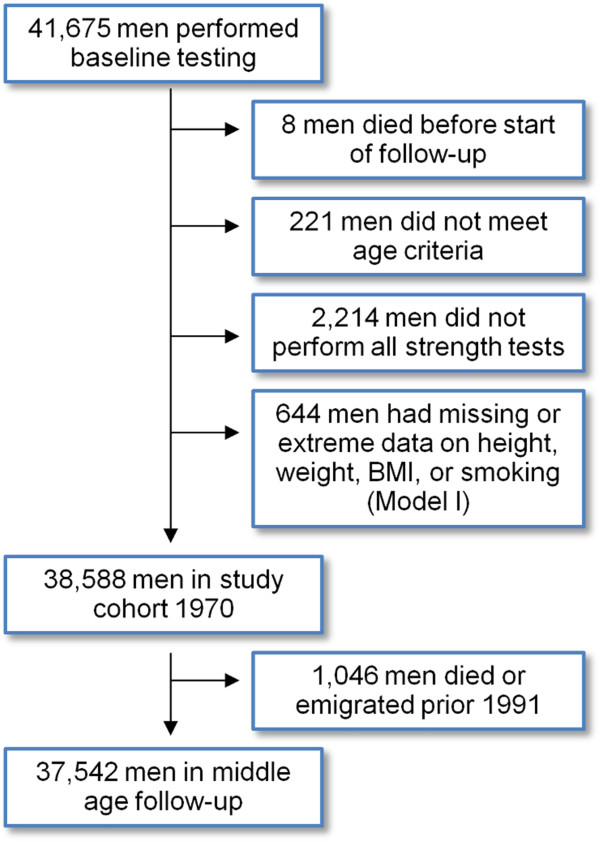
The identification of the study sample and the loss during follow-up.